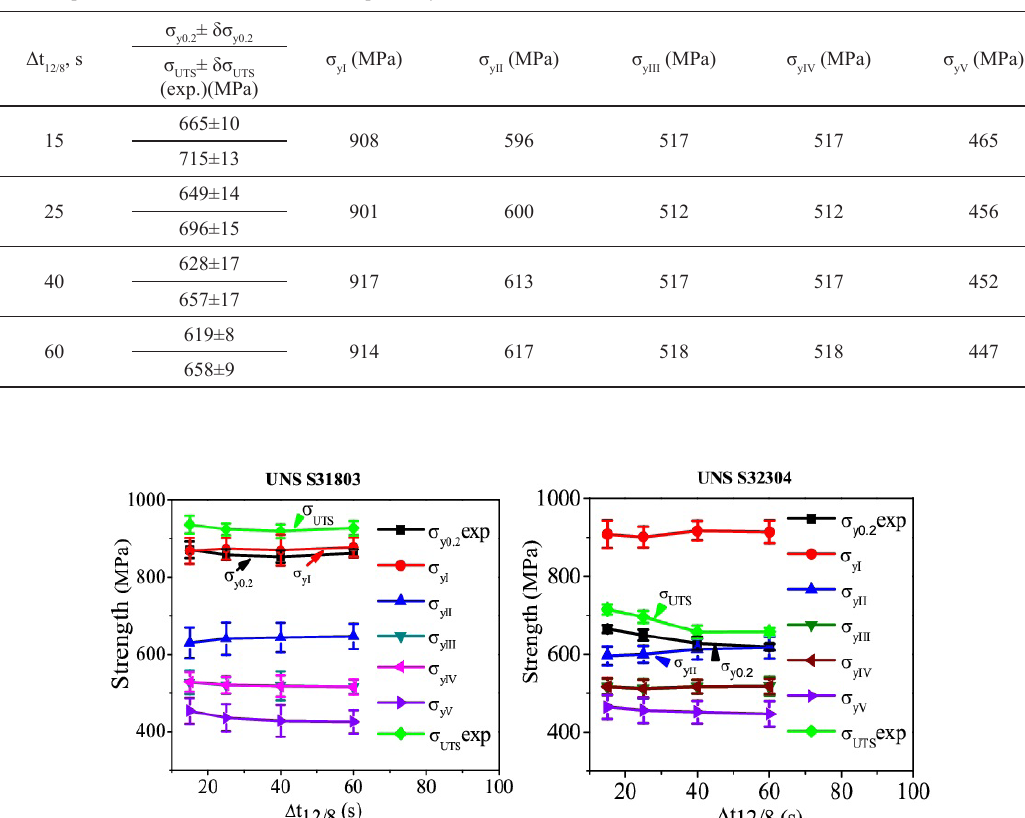
). Yield strength values calculated through the different approaches UTS